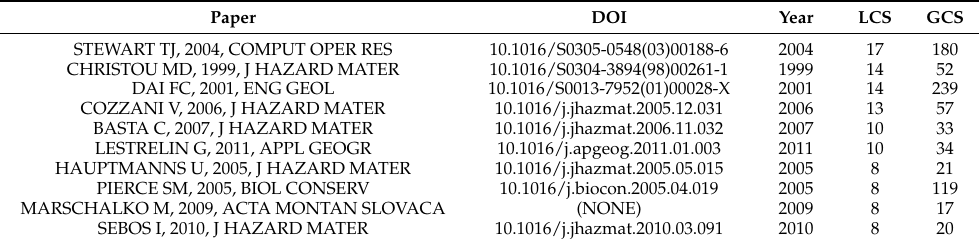
Table 1. Top 10 local citation score (LCS) in the land use planning field. Paper